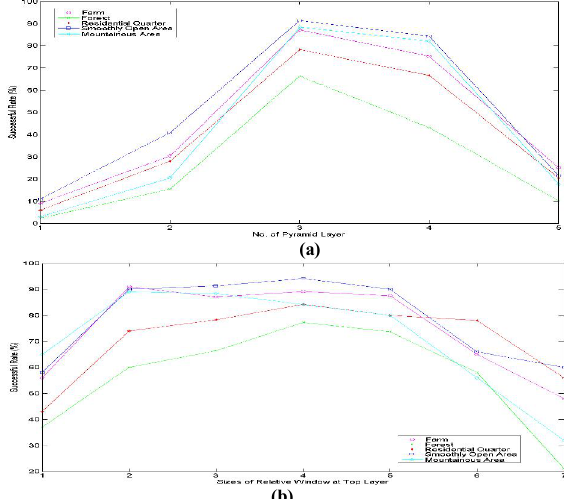
(b) Figure 5. The successful rate of matching using the number of pyramid levels and the size of the relative window at the top level: (a) the effect of different number of pyramid levels; (b) the effect of different size of relative window at top